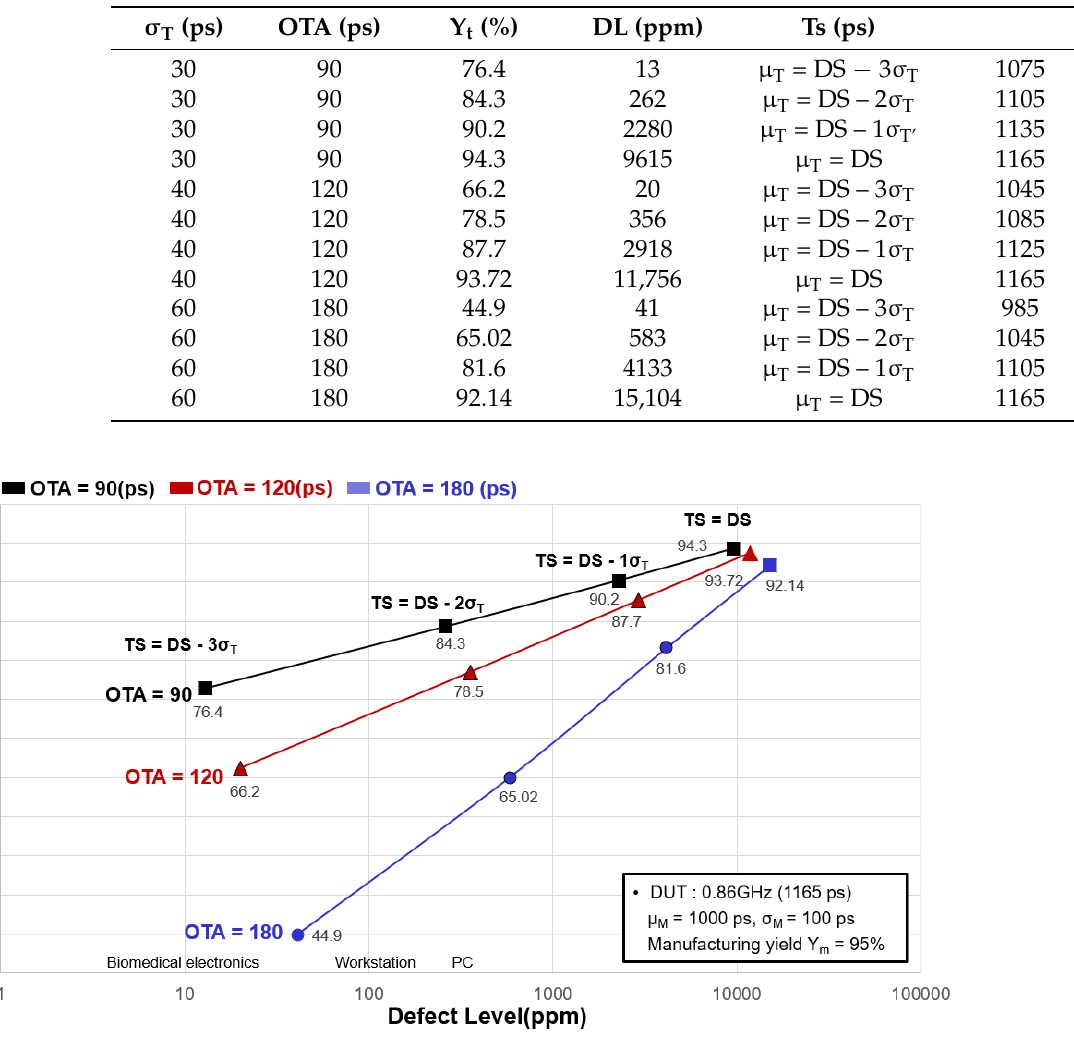
Figure 6. Influence of OTA and TGB of different testers on the test results.